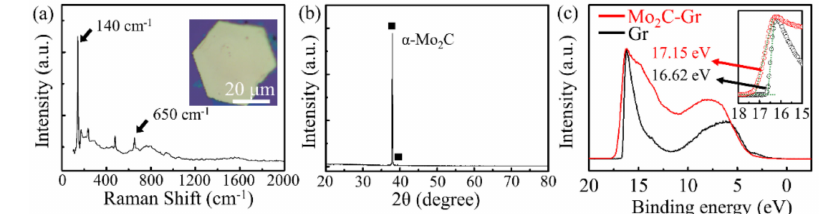
Figure 5. The spectral analysis of Mo2C and Mo 2 C—Gr. ( a ) The Raman spectrum of Mo 2 C. The inset is the optical image of Mo 2 C. ( b ) The X-ray diffraction patterns of Mo 2 C. ( c ) The UPS spectra of graphene ( black ) and Mo 2 C—Gr ( red ) on n-type silicon. The inset of the left panel shows the magnified region from 18 eV to 15